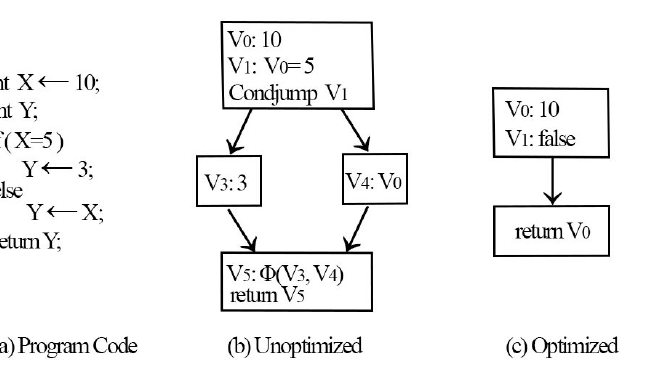
Figure 6. Converting a program code to Minimal SSA form. ( a ) Program code. ( b ) SSA form before on-the-fly optimizations. ( c ) Optimized SSA form of the